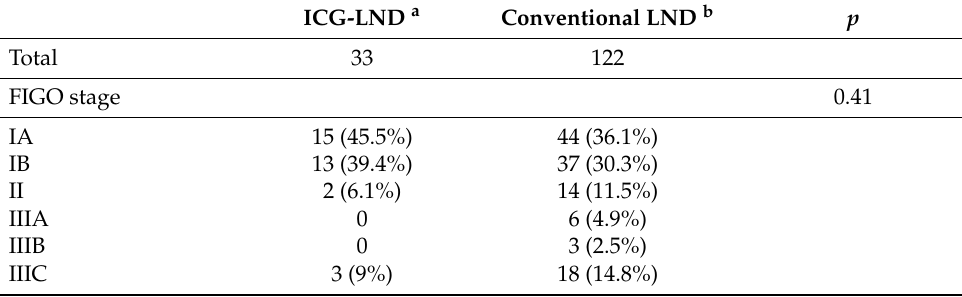
Table 2. Final stage in women affected by endometrial cancer.